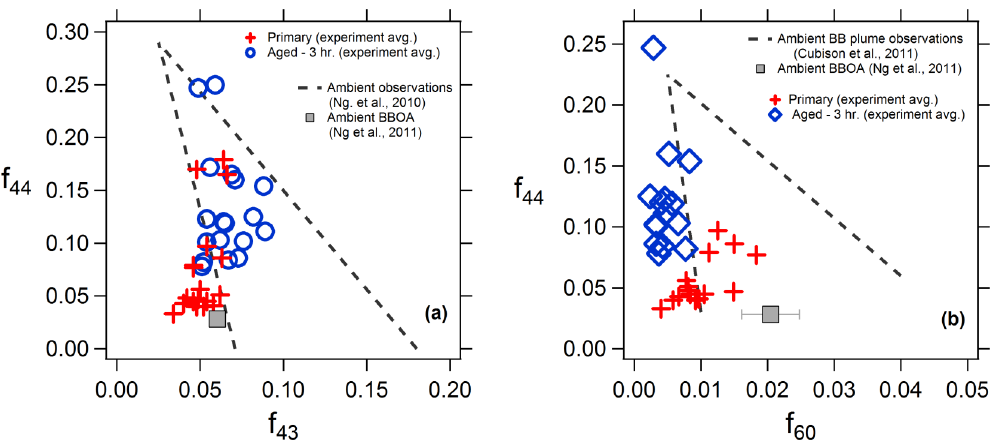
Fig. 6. (a) Comparison of f 44 and f 43 and (b) f 44 and f 60 measured during the primary characterization period and after 3h of photo- oxidation for each experiment. The data in (a) are compared to f 44 and f 43 values from ambient data sets (Ng et al., 2010) and to values from ambient biomass burning organic aerosol (BBOA) spectra derived from factor analysis (Ng et al., 2011). The data in (b) are compared to data from ambient biomass burning plumes (Cubison et al., 2011) and to ambient BBOA spectra derived from factor analysis (Ng et al., 2011). Panel (b) does not contain data from Burns 49, 53, and 59 because of low signal-to-noise in m/z 60